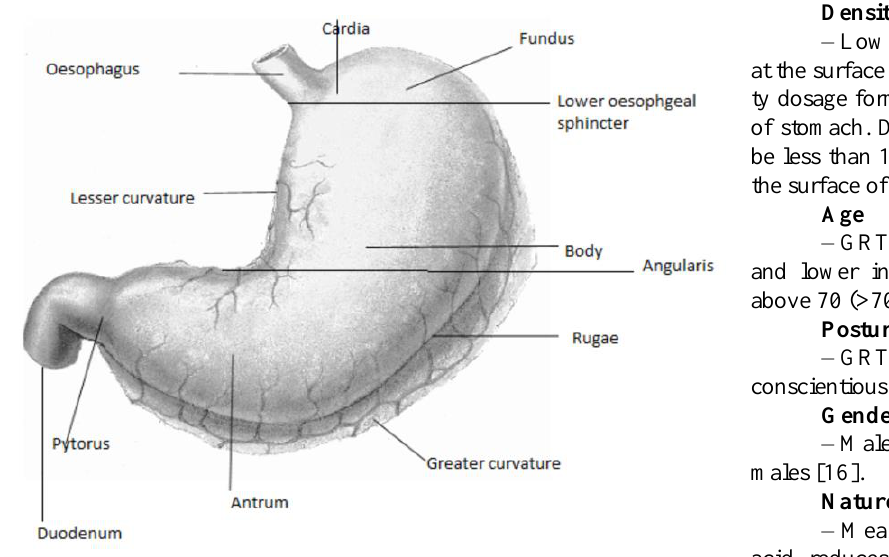
Fig. 1. Various parts of human